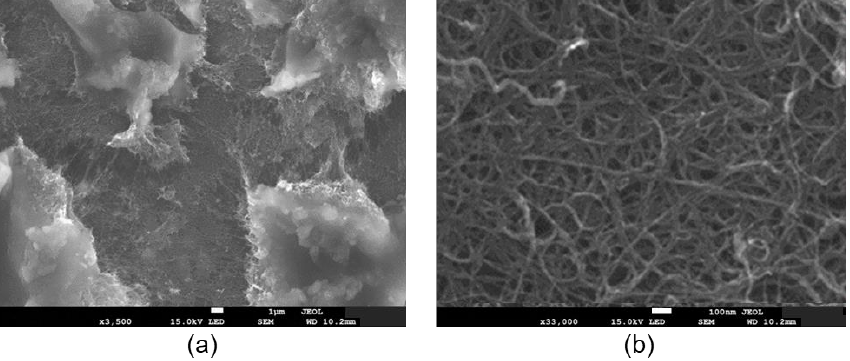
Figure 6. SEM micrographs of PCDTBT/PC 70 BM/MWCNT layer with cast PCDTBT/PC 70 BM on top of the MWCNT layer, where the MWCNTs were deposited ( a ) by electrophoresis and ( b ) by casting of the MWCNT solution.